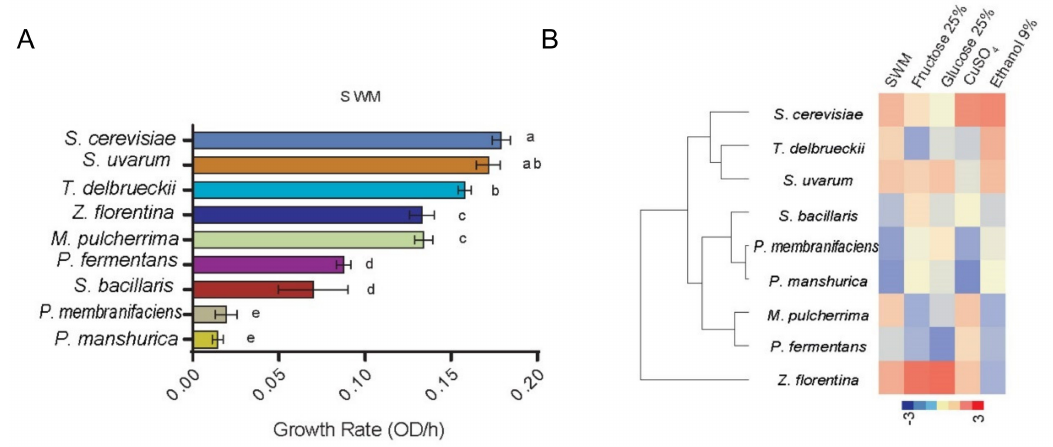
Figure 3. Wine-related phenotypes in natural strains. ( A ) Maximum growth rate ( µ max, OD / h) in synthetic wine must (SWM), a,b,c,d,e depict significant di ff erences (p-value < 0.05, ANOVA). ( B ) Heatmap from all phenotypes evaluated under micro-cultivation